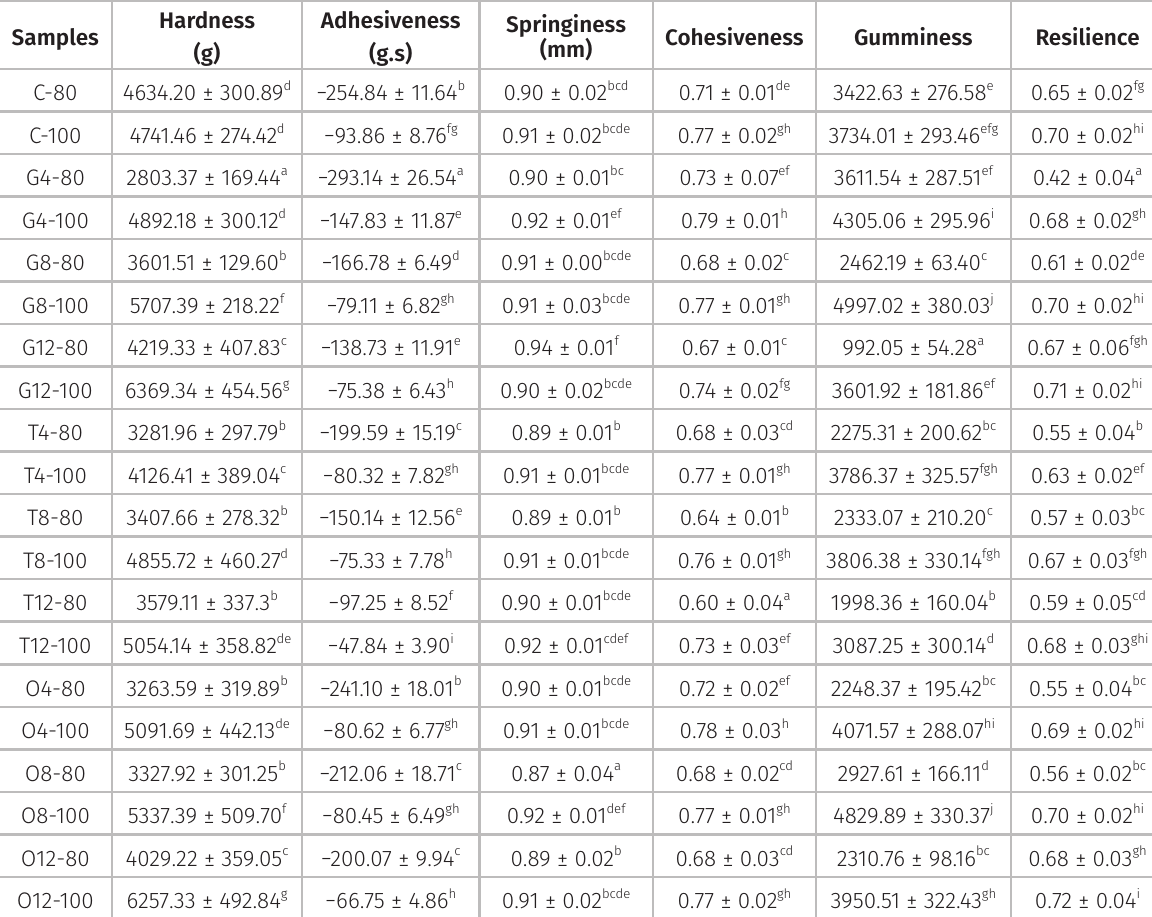
Table III. Textural properties of the noodle samples.